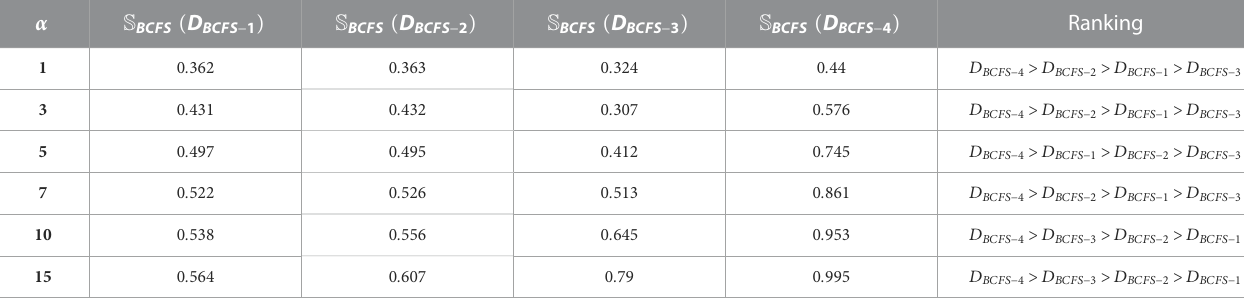
TABLE 10 Score values and ranking order for various values of α using the BCFPDG operator. α